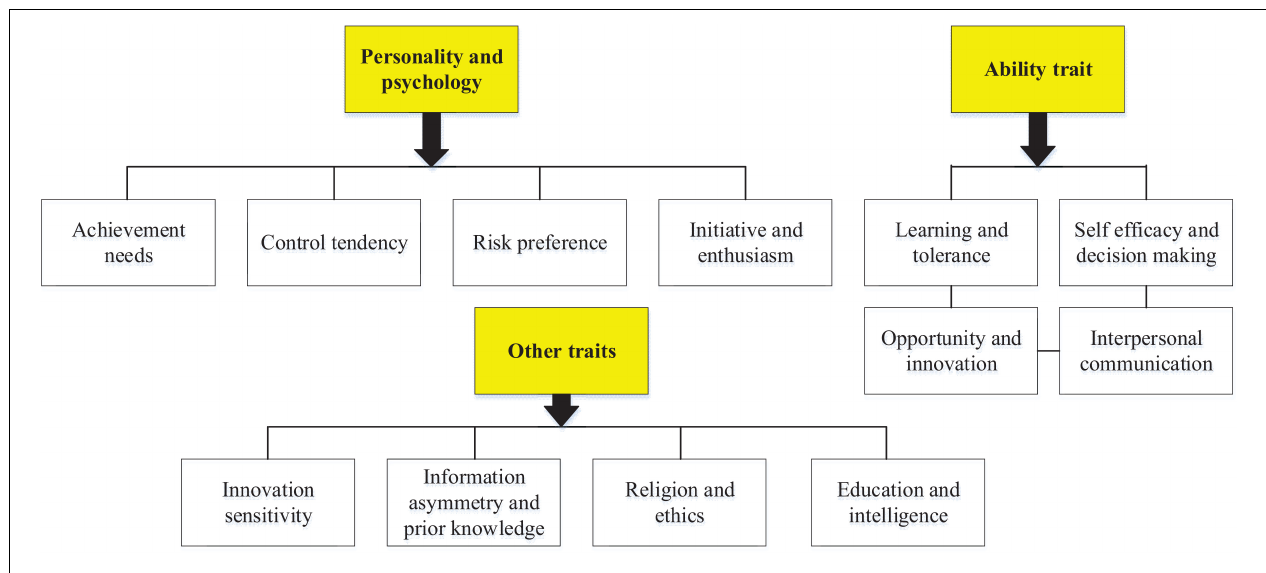
FIGURE 2 | Characteristics of